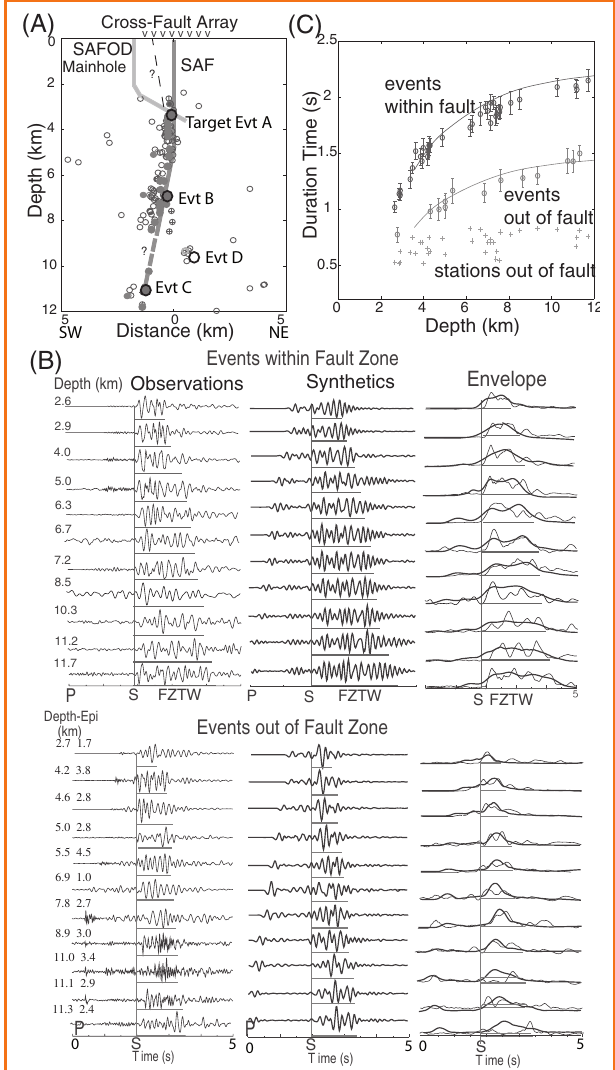
Figure 3. [A] Vertical section across the SAF near the SAFOD mainhole (gray line) shows locations of microearthquakes recorded at our seismic array in 2003. Solid (open) circles denote events showing fault-zone trapped waves (FZTWs) with long (short) wavetrains. The deep part of the SAF (thick line) dips toward SW at a steep angle. Waveforms of events A, C and D are shown in Fig. 2. The branch fault (thin dashed lines) may connect to the main fault at depth. [B] Top: Vertical-component seismograms and envelopes at station ST0 on the SAF main trace for eleven on-fault earthquakes at different depths show an increase in wavetrain length (solid horizontal bar) of FZTWs as event depths increase. S-arrivals for these events are aligned at the same time. Bottom: The same plot but for eleven off-fault events in a similar range of depths shows much shorter FZTW wavetrains and flat changes with event depths. The finite-difference synthetic seismograms and envelopes at station ST0 for these events using the model in Fig. 5A are in general agreement with observations. Event epicenters are 2 km from station ST0 in computation. [C] The measured FZTW wavetrain lengths versus focal depths for on-fault (black circles) and off-fault (gray circles) events were recorded at stations within and out of the fault zone. Each data point is averaged from measurements at four stations for the event. Error bars are standard deviations. Curves are polynomial fits to the data..